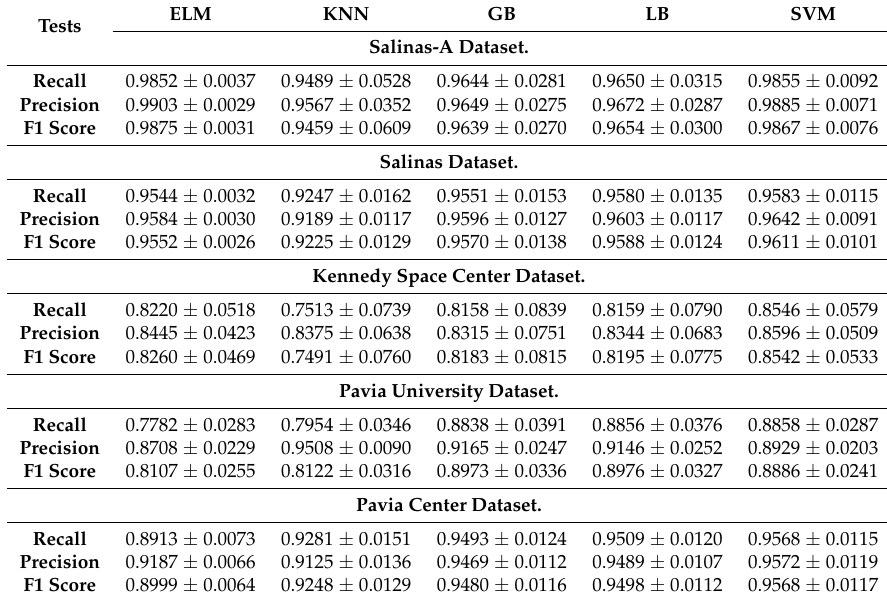
Figure 9. Pavia Center: ( a ) Ground Band, ( b ): True Ground Truths, ( c ): Training Ground Truths, ( d ): Test Ground Truths, and ground truths predicted by ( e ): SVM, ( f ): KNN, ( g ): GB, ( h ): LB, and ( i ): ELM classifier with 2% of selected training samples. Table 3. Statistical applicability of our proposed FSAM samples selection method. Each classifier is trained with 2% of actively selected training